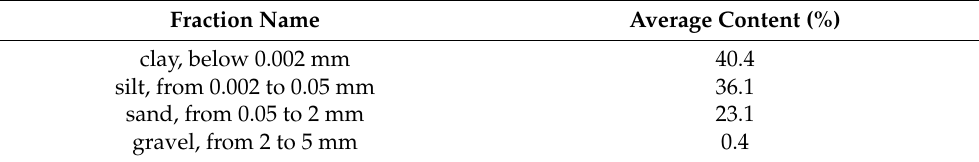
Table 1. Aerometric analysis of Pliocene clays used in the production of tested ceramic building materials (clay masonry units).